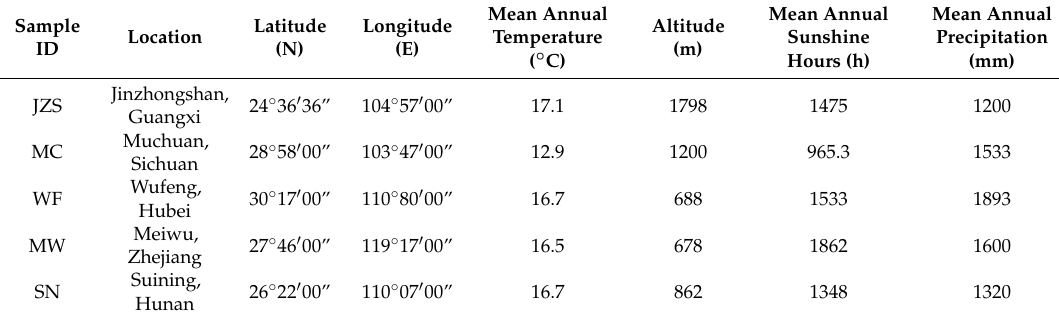
Table 4. Geographical and climatic information of locations for sampling C. paliurus